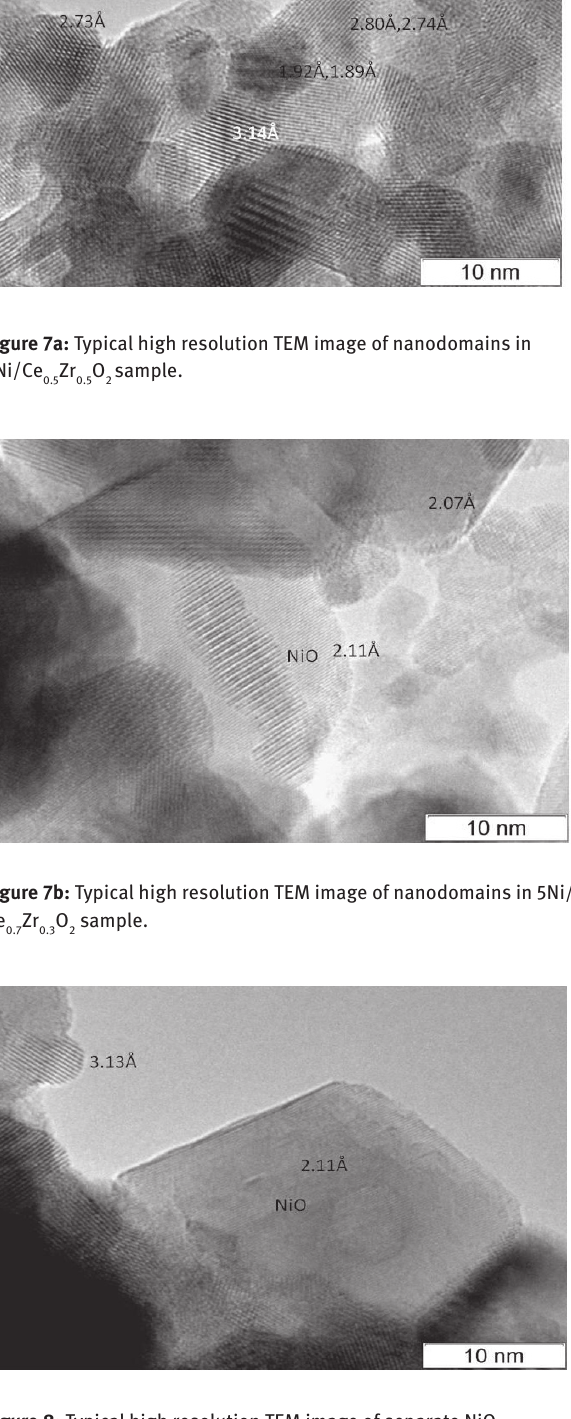
Zr O sample. 0.5 0.5 2